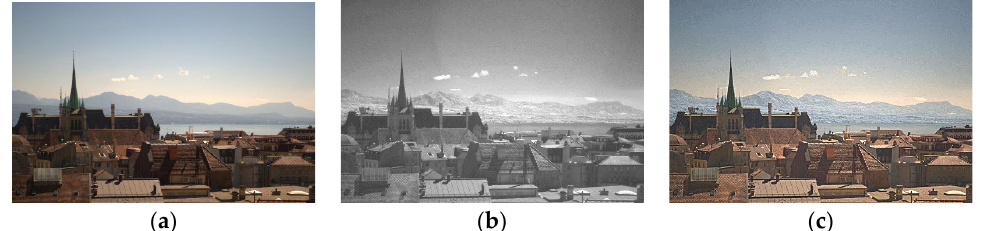
Figure 1. Visible-light and near-infrared input and result images: ( a ) visible image, ( b ) near-infrared image, ( c ) fused